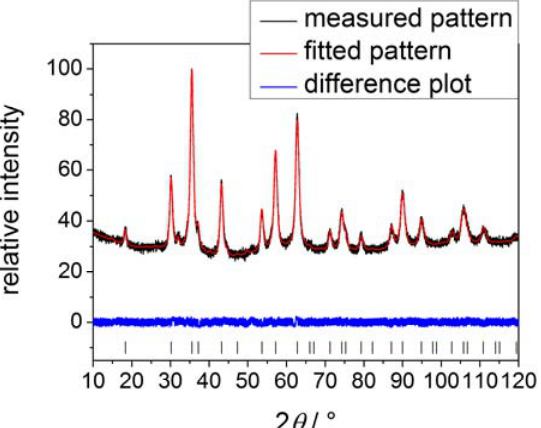
Figure 8. XRD pattern of the obtained particles. The results show that magnetite was